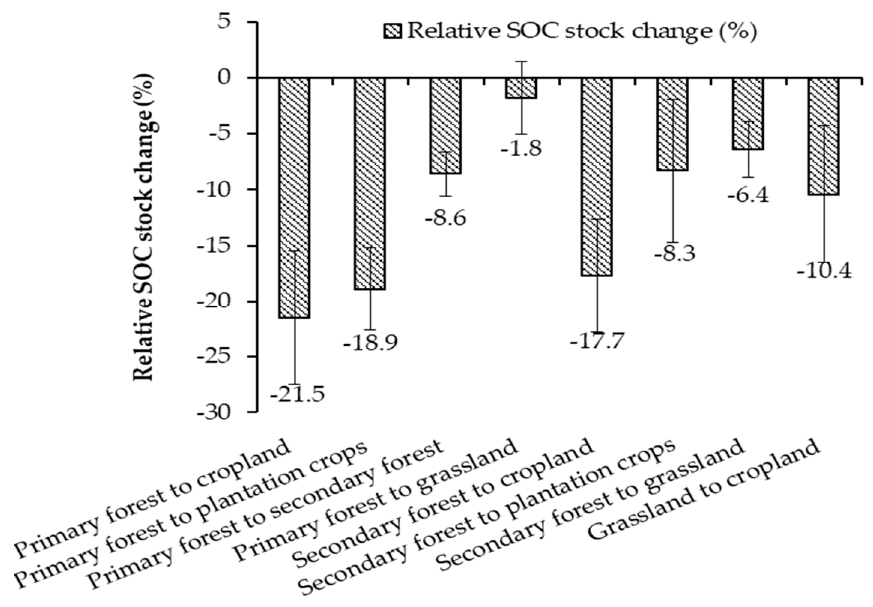
Figure 1. Losses of SOC stock (percent decrease) following land use change across tropical mineral soils (adapted from [17,21,22]).